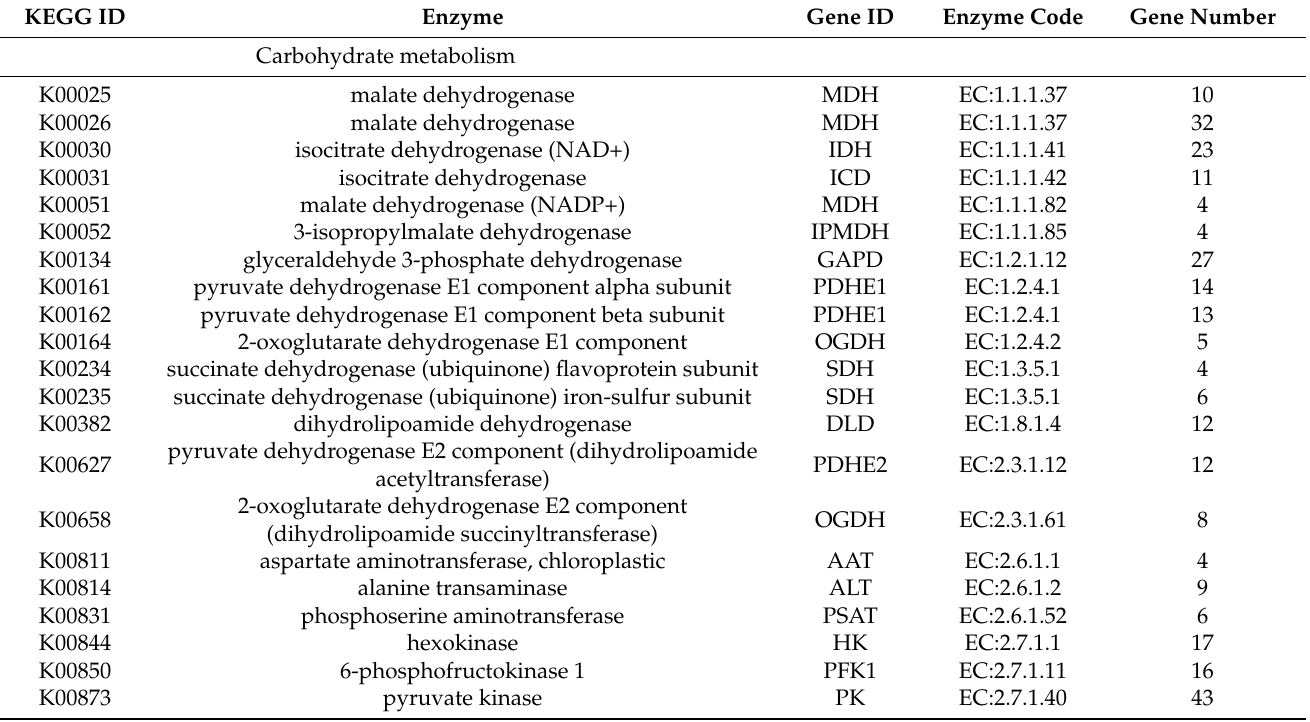
Table 2. List of candidate enzymes and genes comprising carbohydrate metabolism and amino acid biosynthesis pathways involved in A. arguta cv.